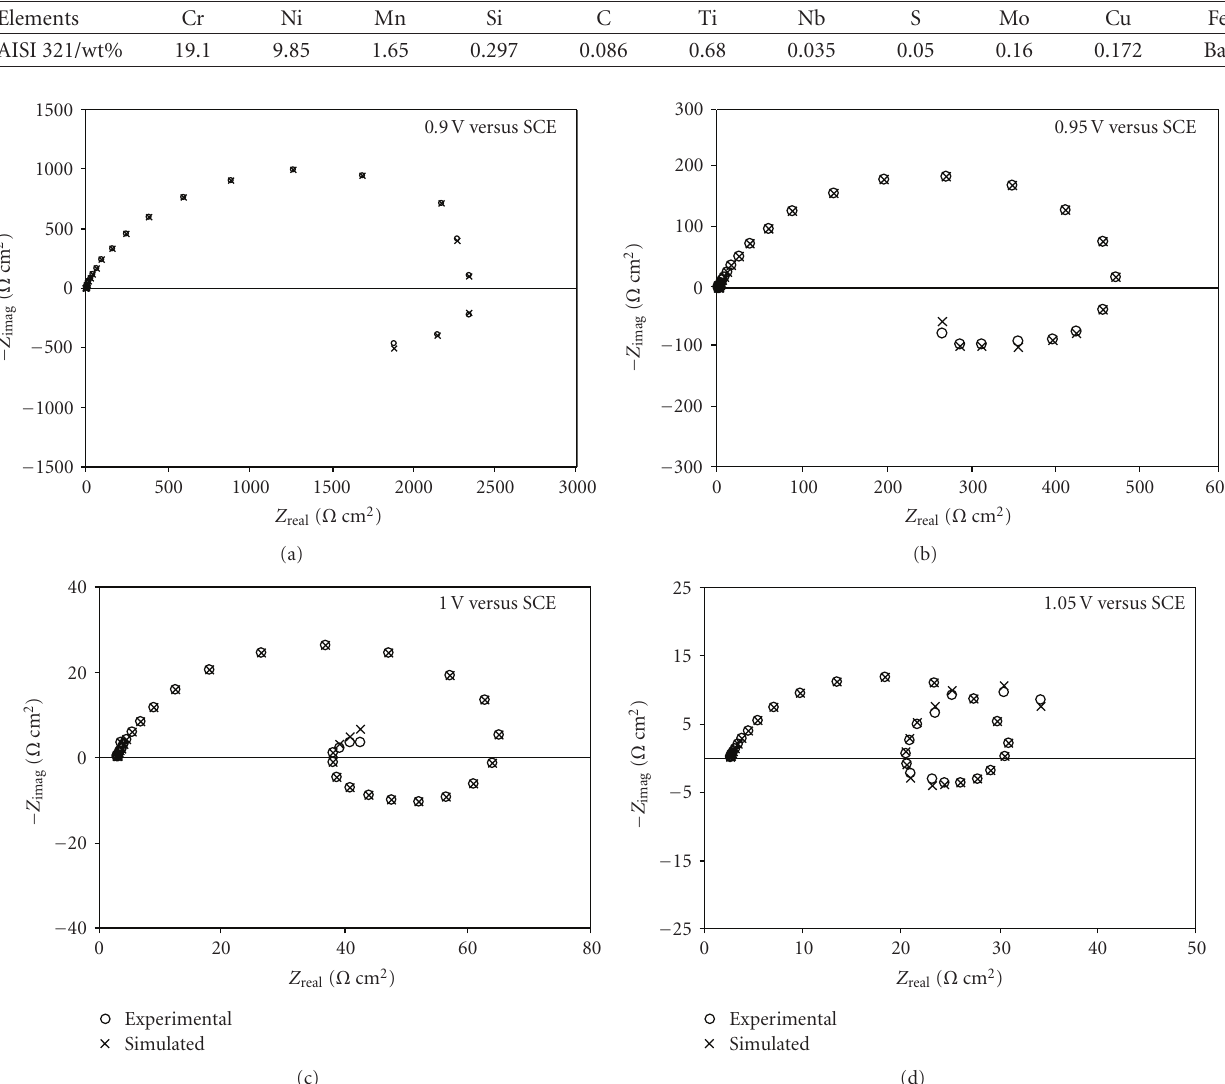
Figure 2: Electrochemical impedance spectra for AISI 321 stainless steel in the transpassive region registered after 30-minute polarization at 0.8 V versus SCE.